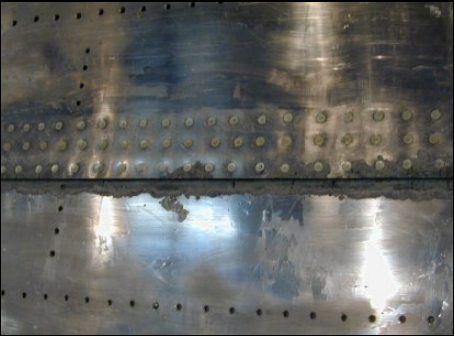
Figure 2 – Fuselage skin of the Boeing 737 Aloha Рис . 2 – Обшивка фюзеляжа самолета Boeing 737 Aloha Slika 2 – Oplata trupa aviona Boeing 737